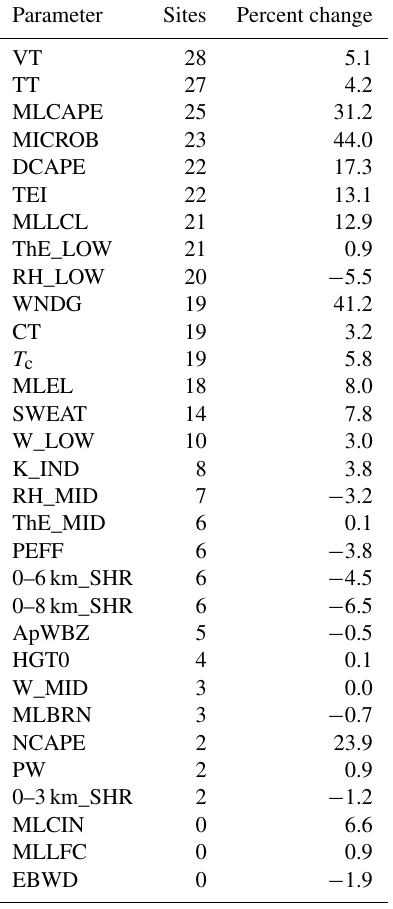
Table 5. Summary of convective parameters on SWS days. The “sites” column indicates the number of spatial subdivisions within which the difference between the SWS mean and the control mean was accompanied by p < 0.10; the “percent change” column shows the relative increase or decrease of the mean on SWS